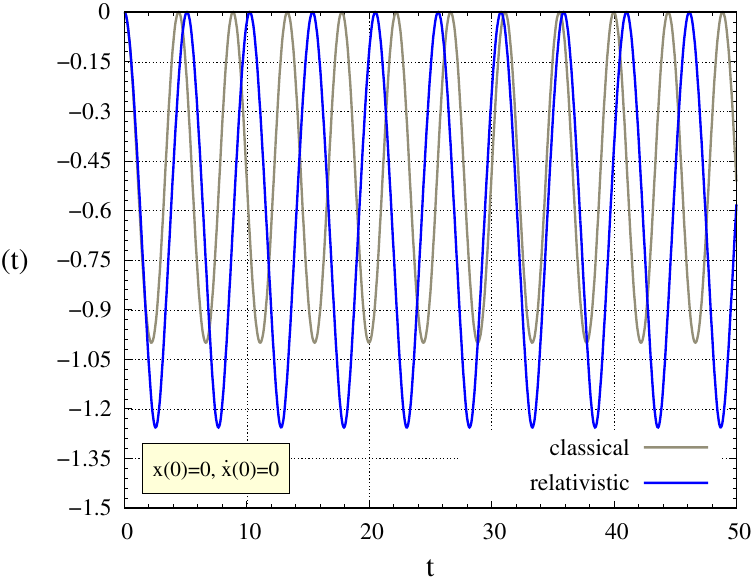
Figure 3. Amplitudes for the relativistic harmonic oscillator compared to the classical model, both suspended in a uniform gravitational field, either using the simple classical solution, viz. Equation (3), or the relativistic estimates resulting by numerical integration of Equations (19a) and (19b). The gravitational field is strong with g / c 2 ∼ 1m − 1 , choosing again all parameters unity, except for k = 2kg/s 2 , see Figure 2. The two initial conditions are x ( 0 ) = ˙ x ( 0 ) = 0, see Equation